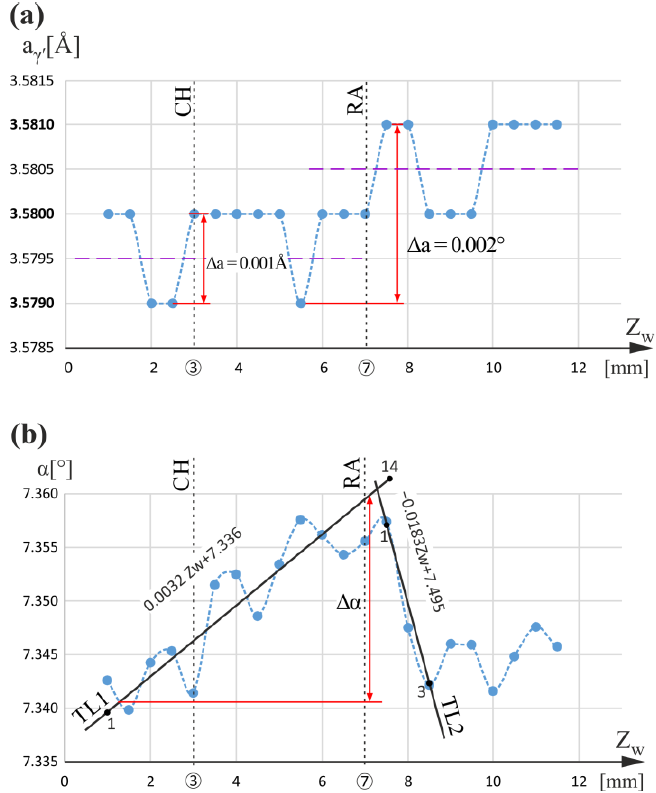
Figure 3. Graphs of the a γ′ (Z w ) ( a ) and α(Z w ) ( b ) relationships obtained for measurement line w. Z w is parallel to Z.